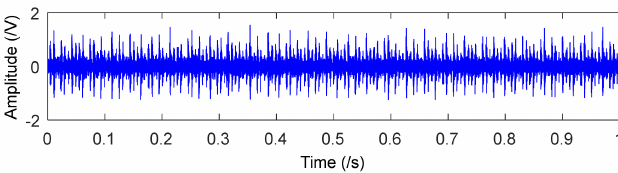
Figure 16. The time waveform of the original signal with an inner race defect.